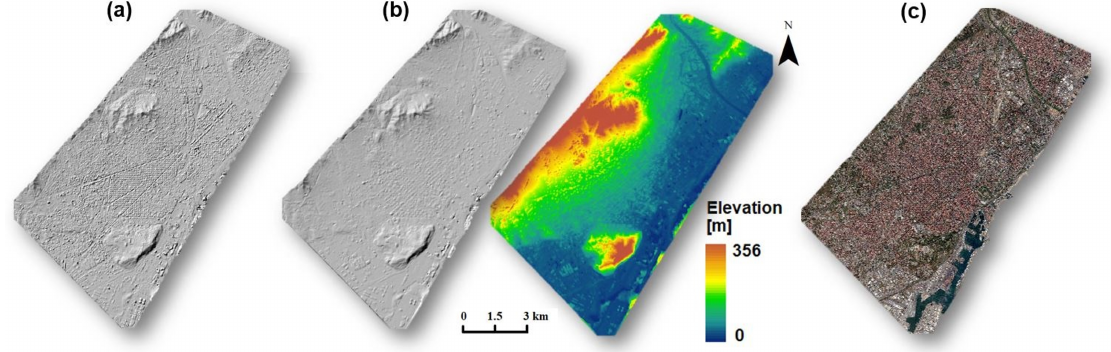
Figure A5. Barcelona digital models: ( a ) shaded view of the reconstructed DSM; ( b ) shaded and color-coded view of the DTM; ( c )